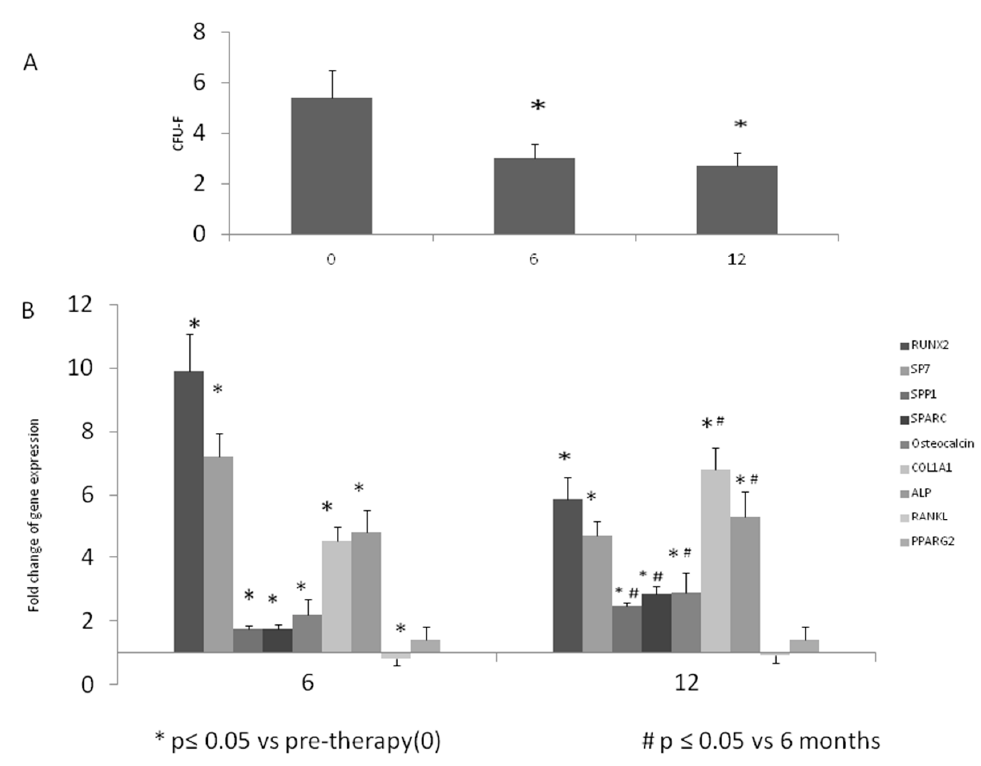
Figure 3. Peripheral blood derived-MSCs and osteogenic differentiation after ZA infusion. Cellular and molecular analyses display the reduction of Colony Forming Unit-Fibroblastic (CFU-F) ( A ) and the increase of osteogenic expression ( B ) during the treatment. The values are representative of 22 patients at each observation time. Three independent qRT-PCRs were performed at the same time for each gene. The overall information suggests an enhanced osteoblastogenesis in ZA-treated patients. (* p < 0.05 vs. pre-therapy; # p < 0.05 vs. 6